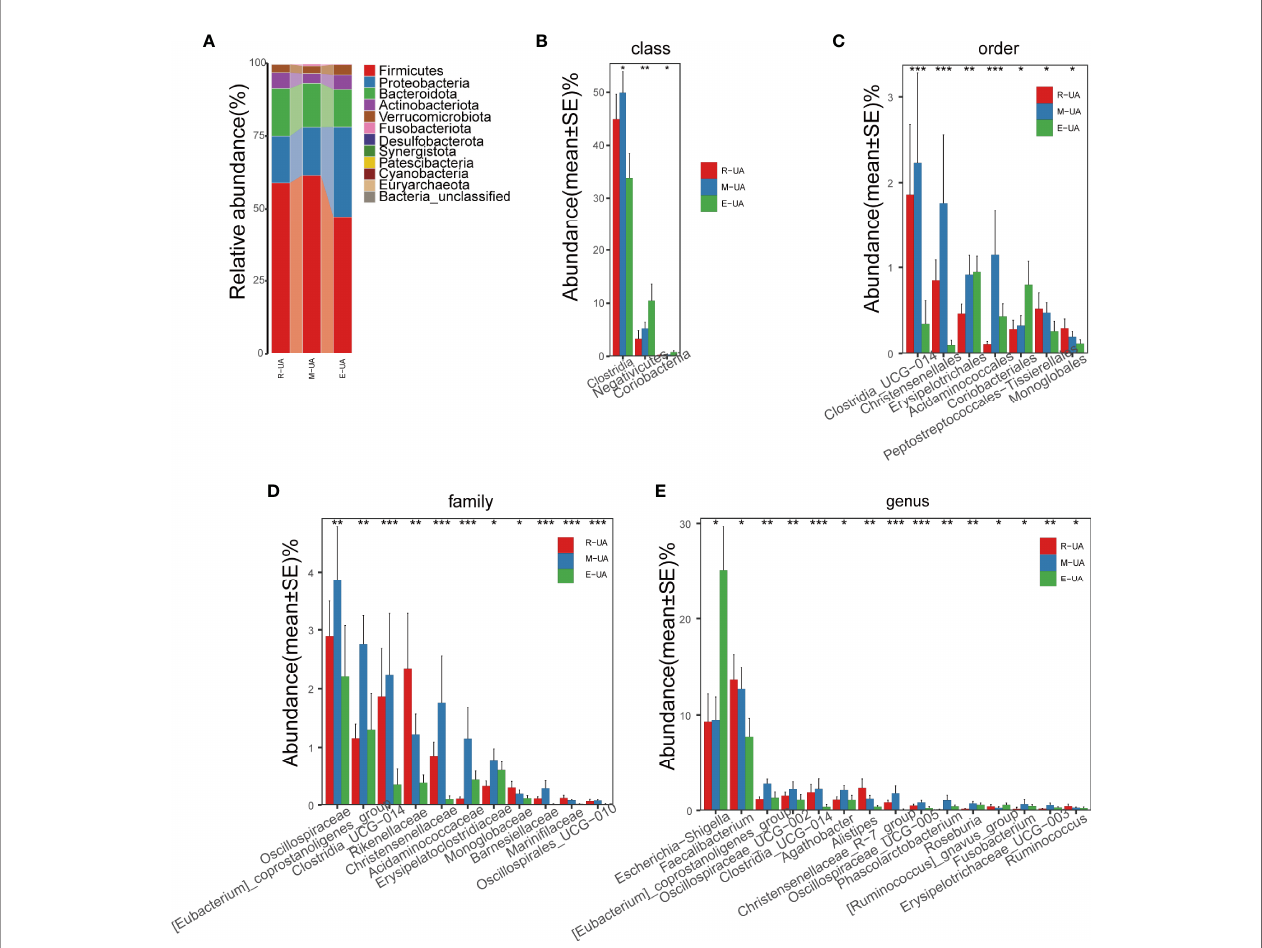
FIGURE 4 | Composition of the microbial communities in the R_UA, M_UA, and E_UA groups. (A) R_UA and M_UA had similar average abundance at the phylum level, but Firmicutes and Bacteroides of E_UA were lower than those of the above two groups. (B – E) Relative abundance were signi fi cantly different between E_UA and the other two groups. R_UA, reduced uric acid; M_UA, moderate uric acid; E_UA, elevated uric acid. *p < 0.05, **p < 0.01, ***p <